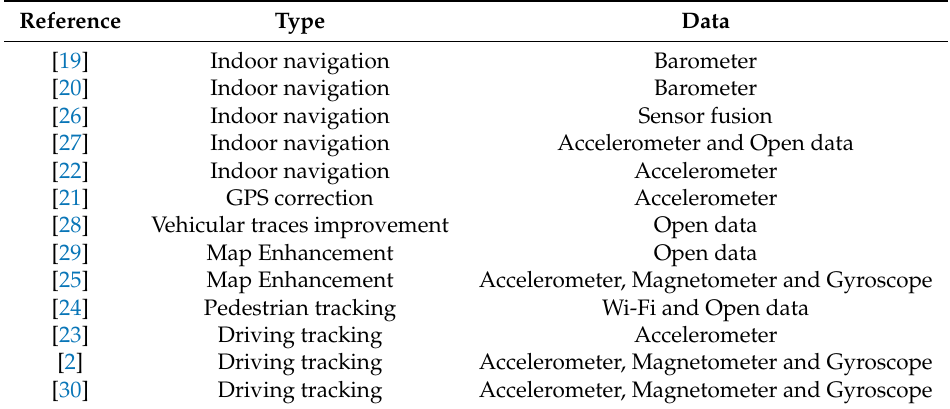
Table 1. Related work